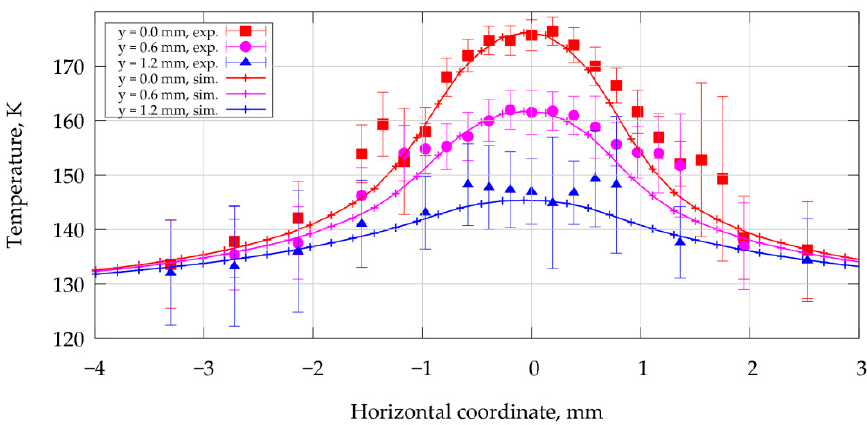
Figure 5. Cross-sections of the vertical distribution of the equivalent temperature. “exp.” denotes experimental data, and “sim.”—simulated data. The average absorbed pump power is estimated to 105 ± 3 W.